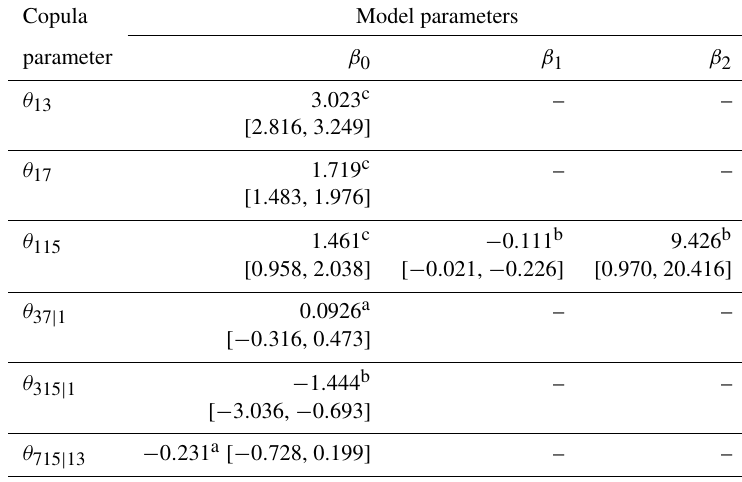
Table 3. Results of nonstationary analysis for the dependence structure of (Q 1 , V 3 , V 7 , V 15 ) . Copula